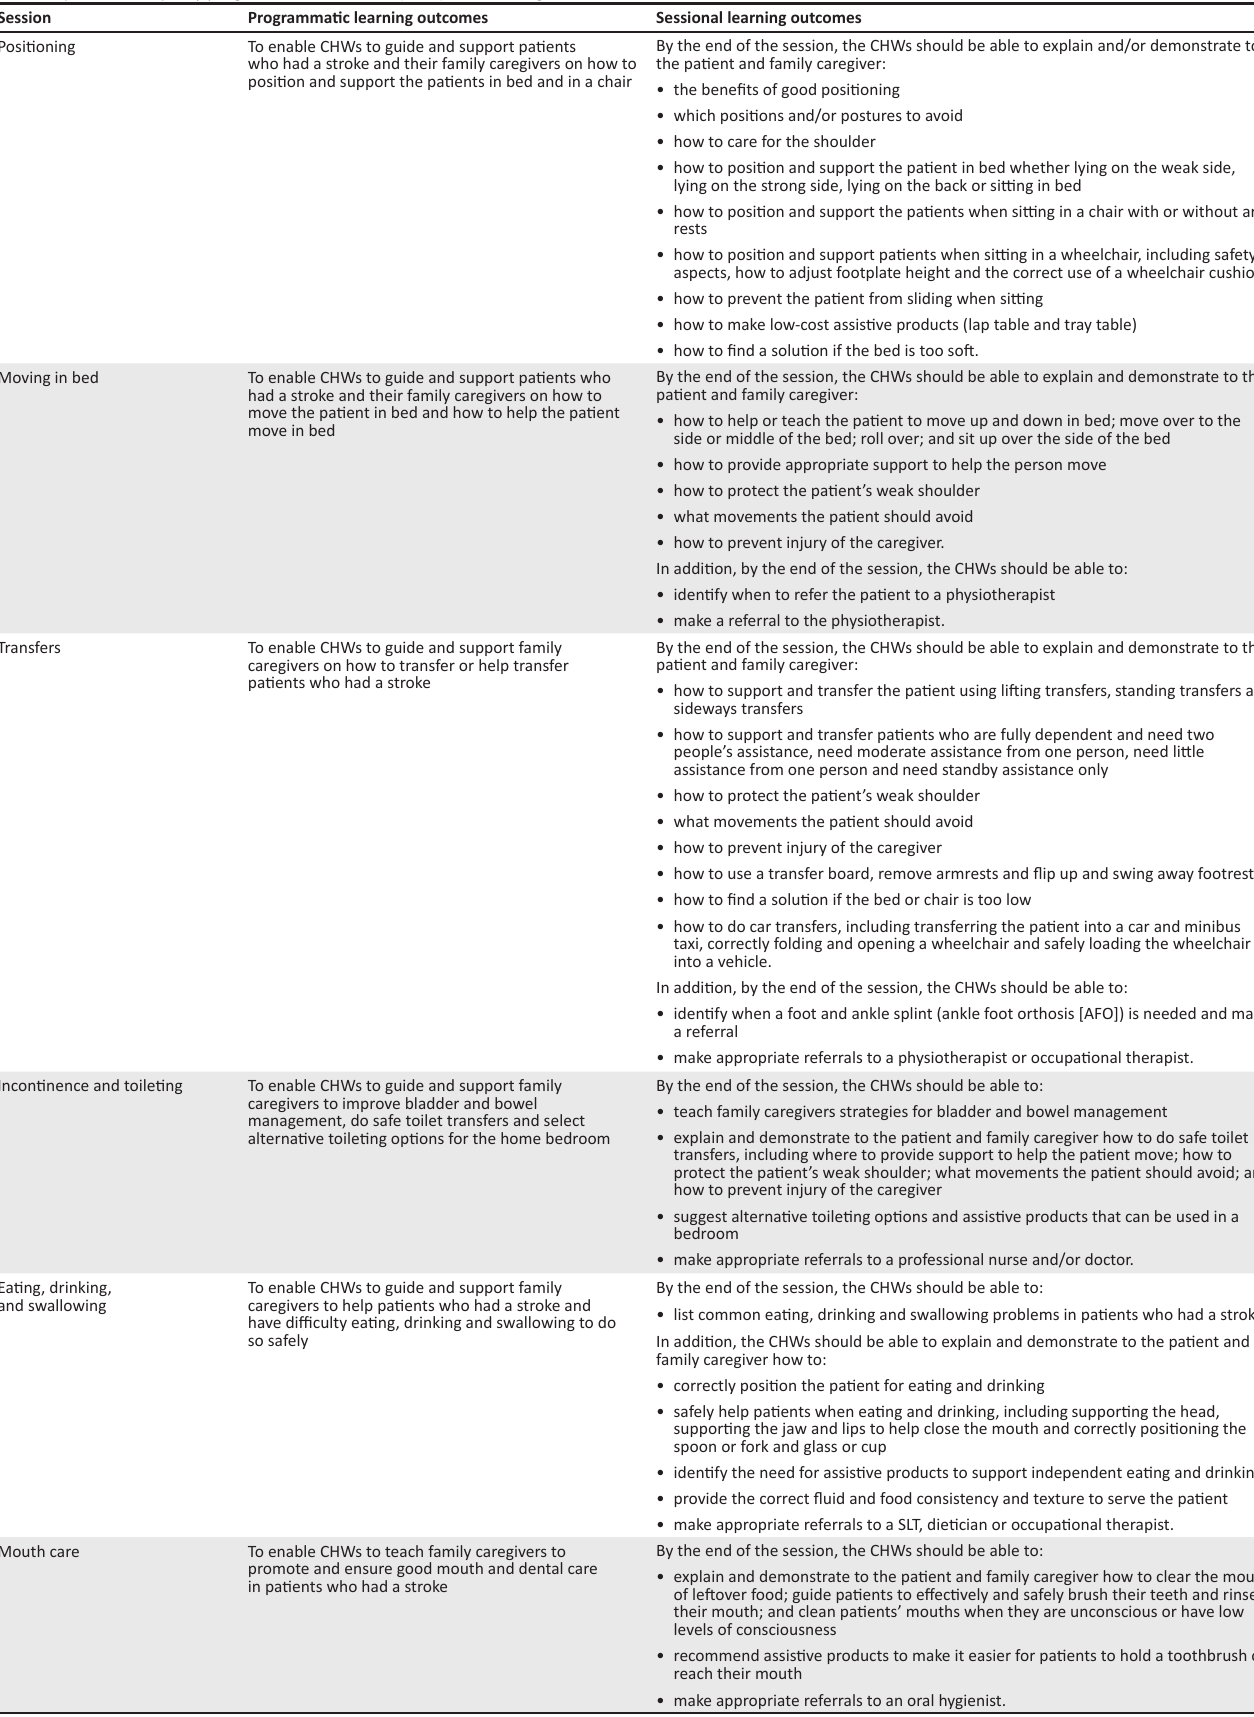
TABLE 5 (Continues...): Key programmatic outcomes (aims) and learning outcomes of the 16 sessions.